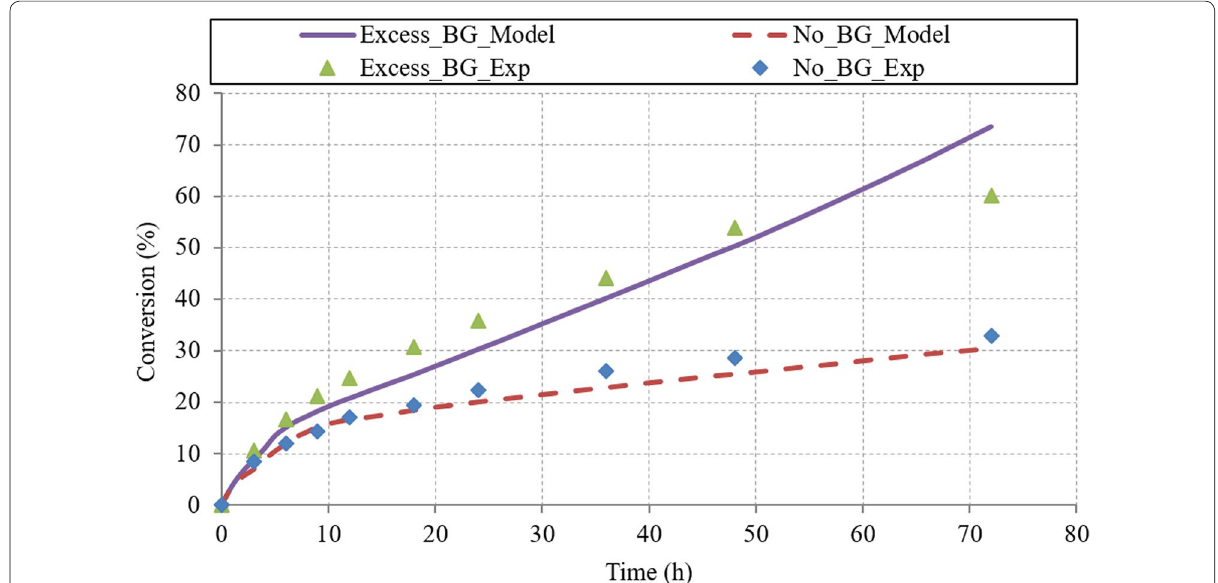
Fig. 12 Effect of β-glucosidase addition on cellulose hydrolysis by CBH I (25 g/L filter paper; CBH I: 10 mg/g